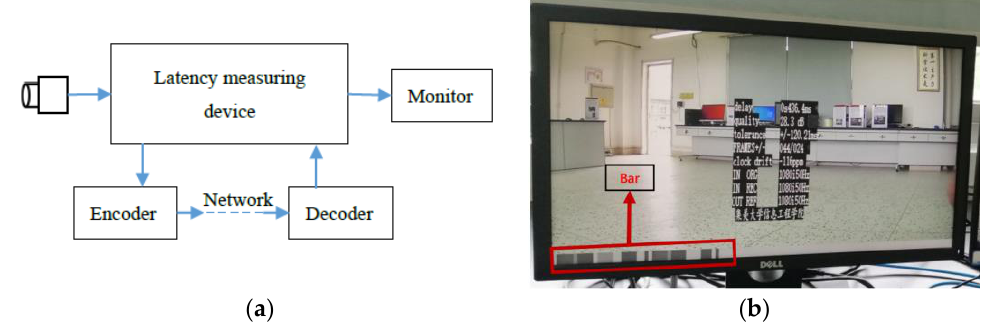
Figure 3. ( a ) Timecode latency measurement scheme; ( b ) Spline Bar in the screen. ”bar” indicates the timecode. The picture contains Chinese words: “School of Information Engineering, Jimei University” .